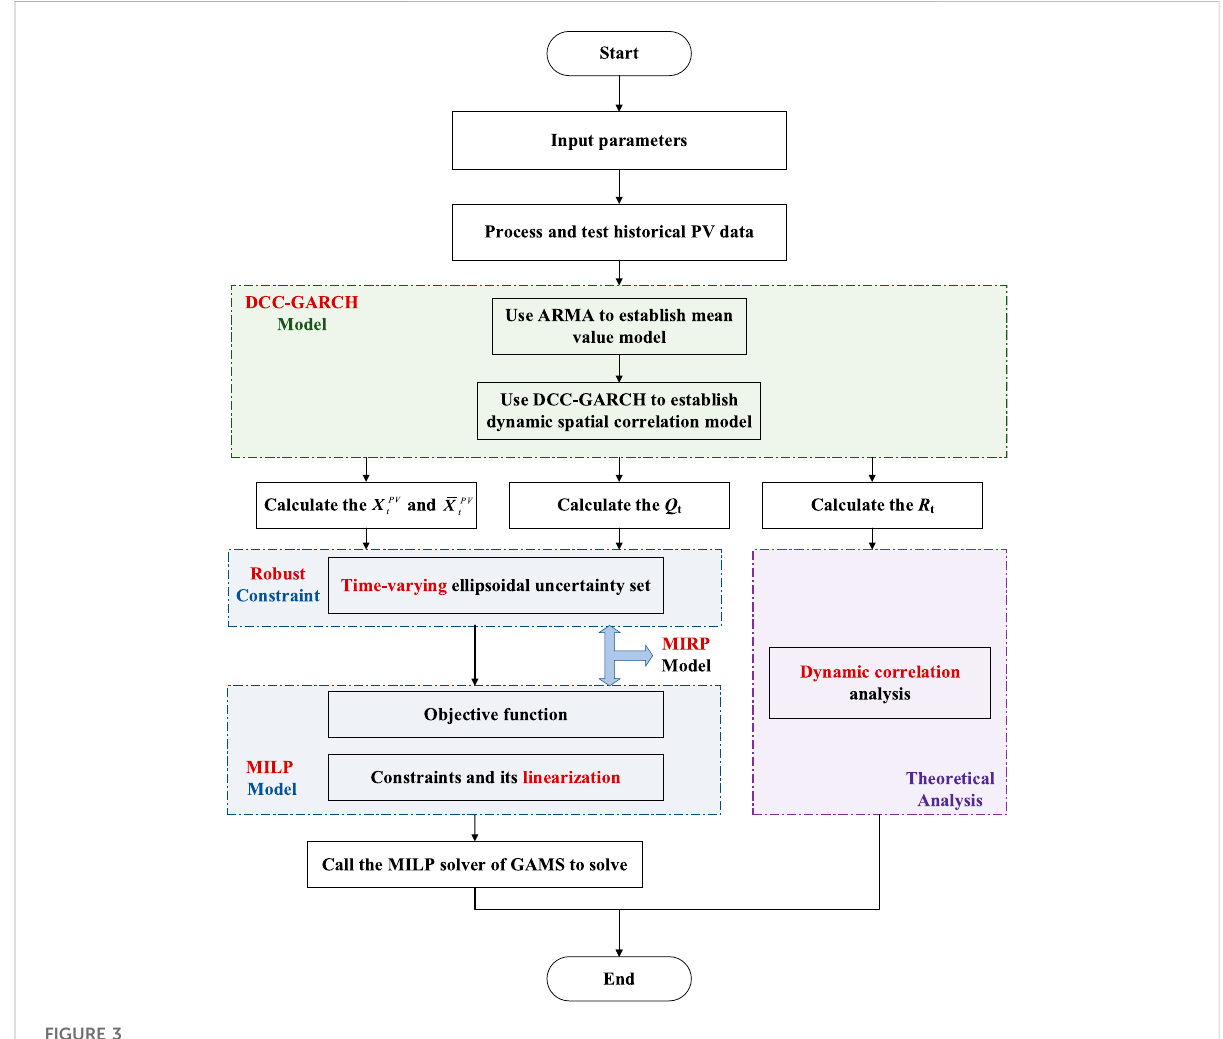
FIGURE 3 Flowchart of the robust dispatching model of ADN considering PV time-varying spatial correlation